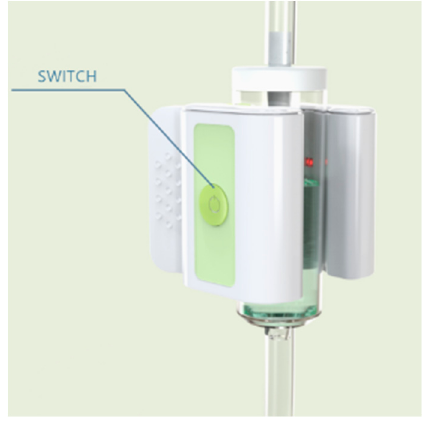
Figure 1. Droplet counter working diagram.